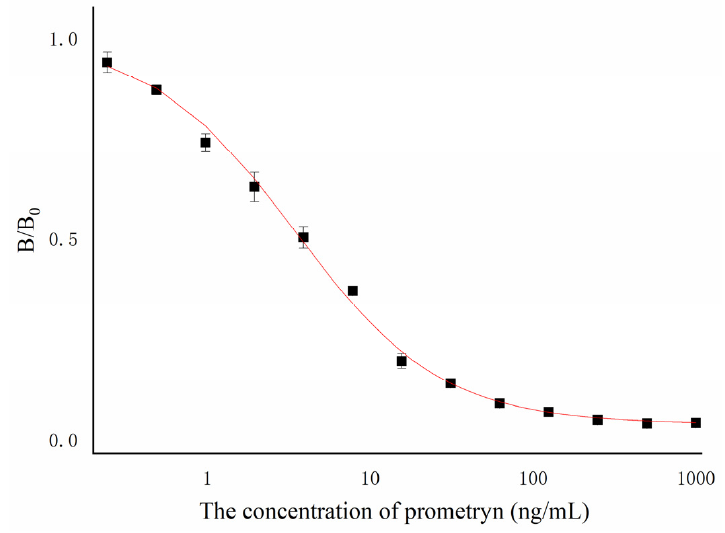
Figure 4. Ic-ELISA standard curve of the 7D4 mAb. (B 0 : OD 450nm value of the control hole without inhibitor added; B: OD 450nm value of the hole with inhibitor added; B/B0 is called binding rate.)